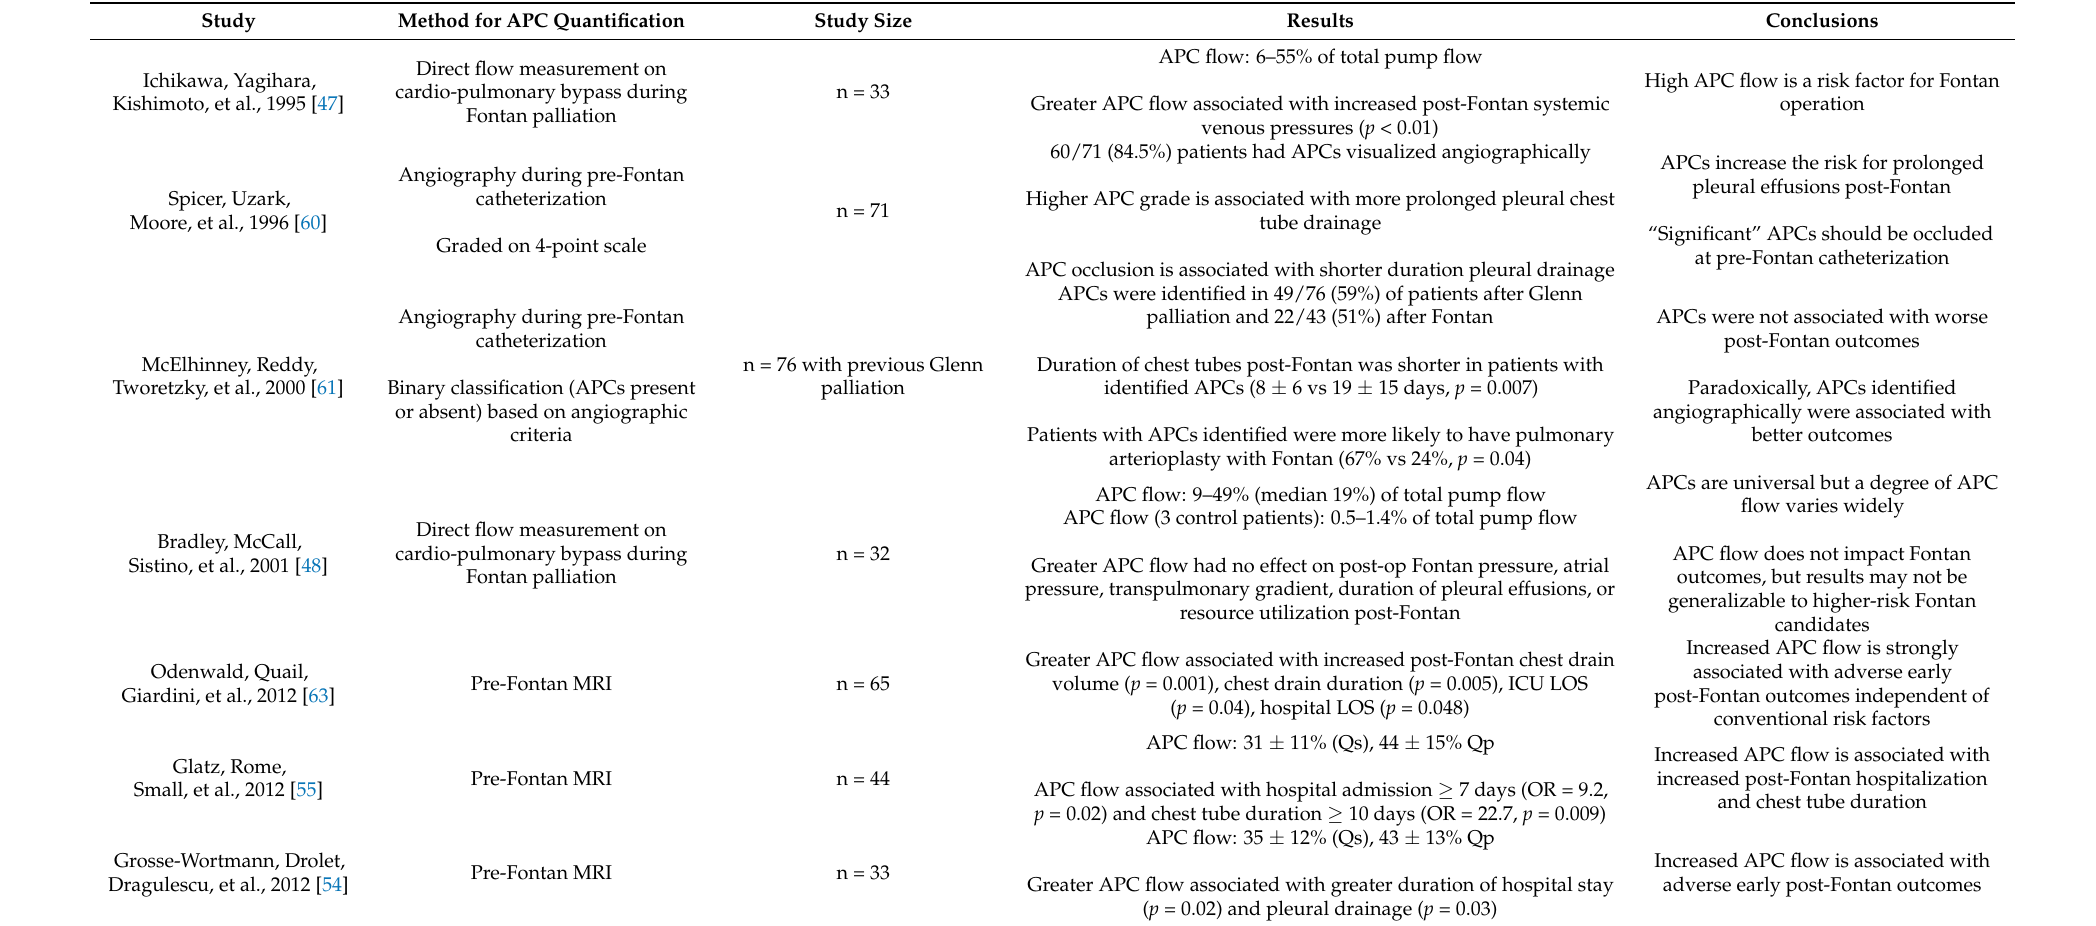
Table 2. Studies investigating the impact of APC flow on clinical